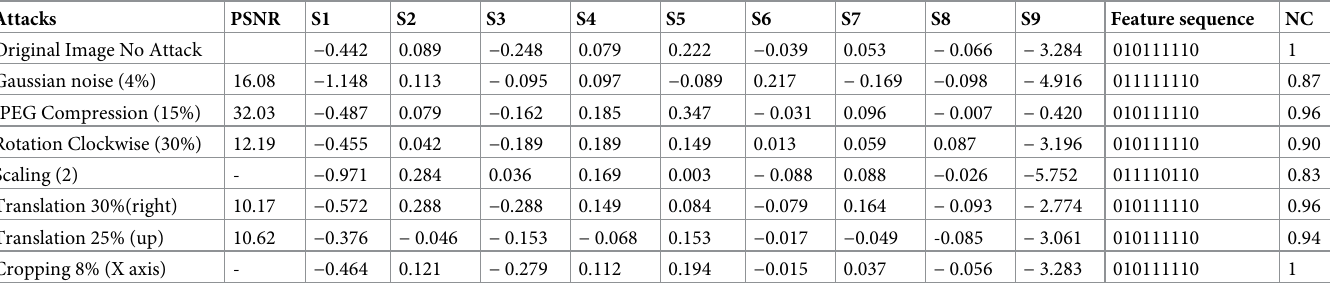
Table 1. SURF-DCT coefficient changes by different attacks for the original image (set of features S1 to S9). Attacks